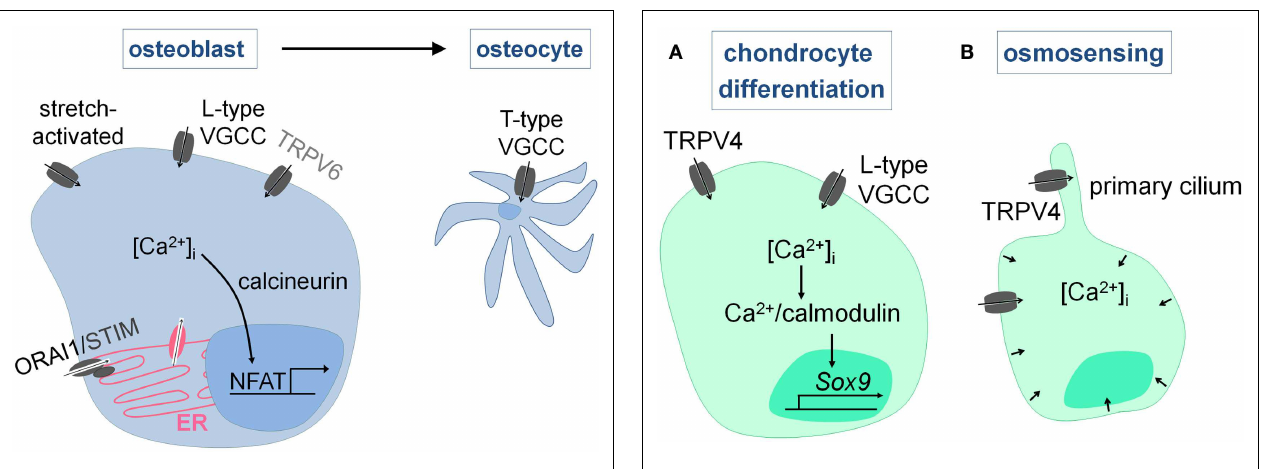
FIGURE 4 | Intracellular Ca 2 + signaling in osteoblasts. Osteoblasts express stretch-activated, voltage-gated (VGCC), store-operated (ORAI1), andTRP (TRPV6) Ca 2 + channels.The response to mechanical stimuli involves Ca 2 + entry via L-type (osteoblasts) andT-type (osteocytes)VGCC’s. In addition, it is known that osteoblast differentiation requires the activation of NFAT-mediated gene transcription by Ca 2 + /calcineurin.The Ca 2 + entry pathways are incompletely characterized but ORAI1 is likely involved.